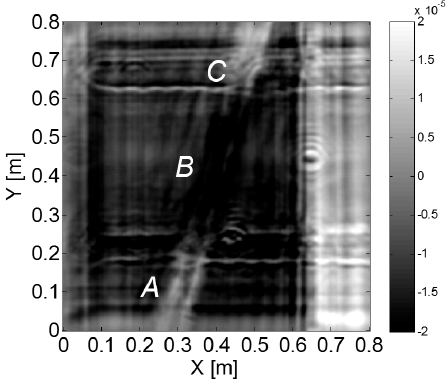
Figure 8. Reconstructed SAR image of the 2D survey on the Type II wall specimen in Figure 1b at a depth of 2.3 cm from the wall surface in HH polarization channel.